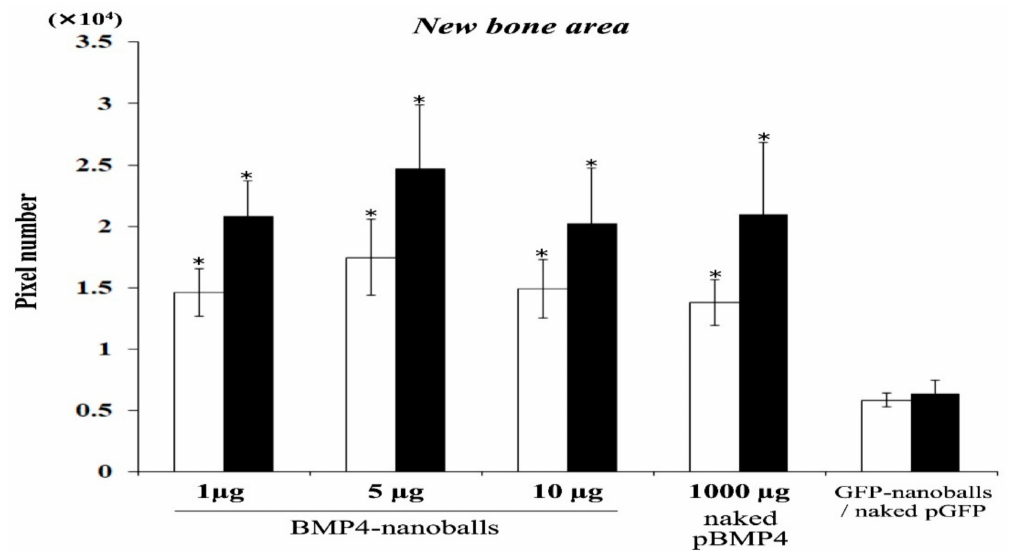
Figure 8. Quantification of augmented bone area at 4- and 8-weeks post-transplantation ( n = 25 per group, * p <